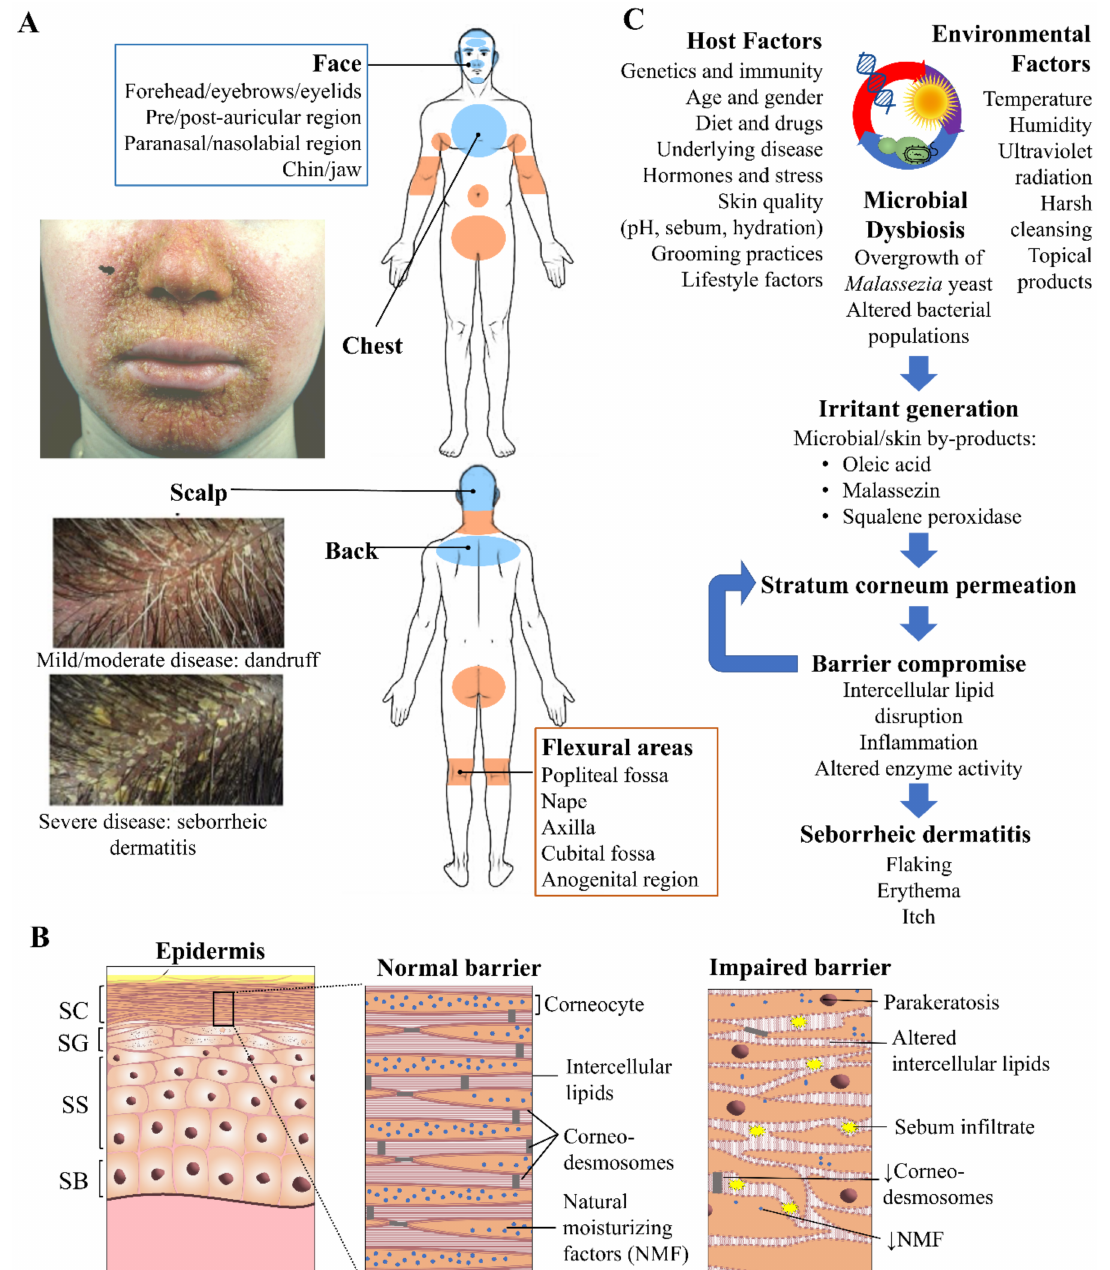
Figure 1. Seborrheic dermatitis and the skin. ( A ) Overview of the distribution pattern of seborrheic dermatitis with accompanying clinical photographs of selected regions. Veraldi et al. (2020), reproduced with permission [14] and Schwartz et al. (2015), reproduced with permission [15]. ( B ) Epidermal structure highlighting key features of the normal stratum corneum (SC) barrier and impaired barrier in seborrheic dermatitis. Proliferation of keratinocytes occurs exclusively from the stratum basale (SB). As these cells progressively travel upwards differentiation occurs in the stratum spinosum (SS) and granulosum (SG), resulting in the cornified cells of the SC, which are continuously shed from the skin surface by the process of desquamation. ( C ) Flow schematic demonstrating the interplay of microbial, host and environmental factors that drive seborrheic dermatitis